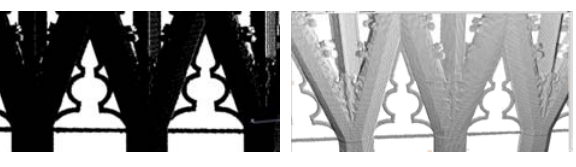
Figure 9. the visualization of the cloud before reducing it (on the left) and after (on the right).